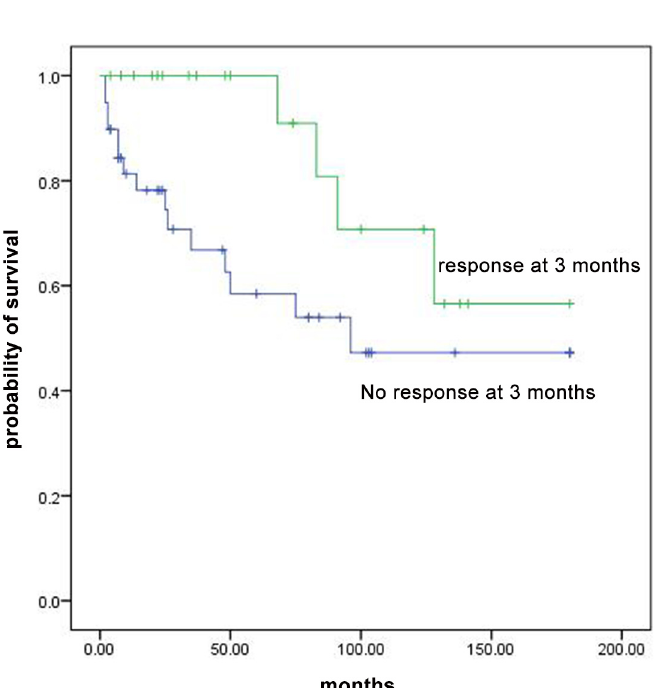
Fig 2. Overall survival curves for patients with AA who responded at 3 months and non